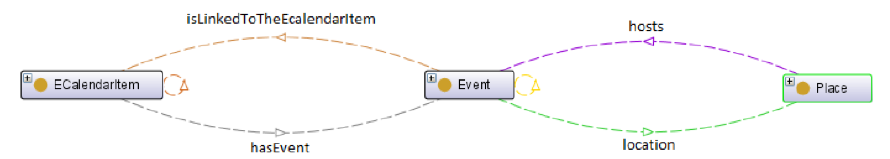
Figure 5. Event and place.